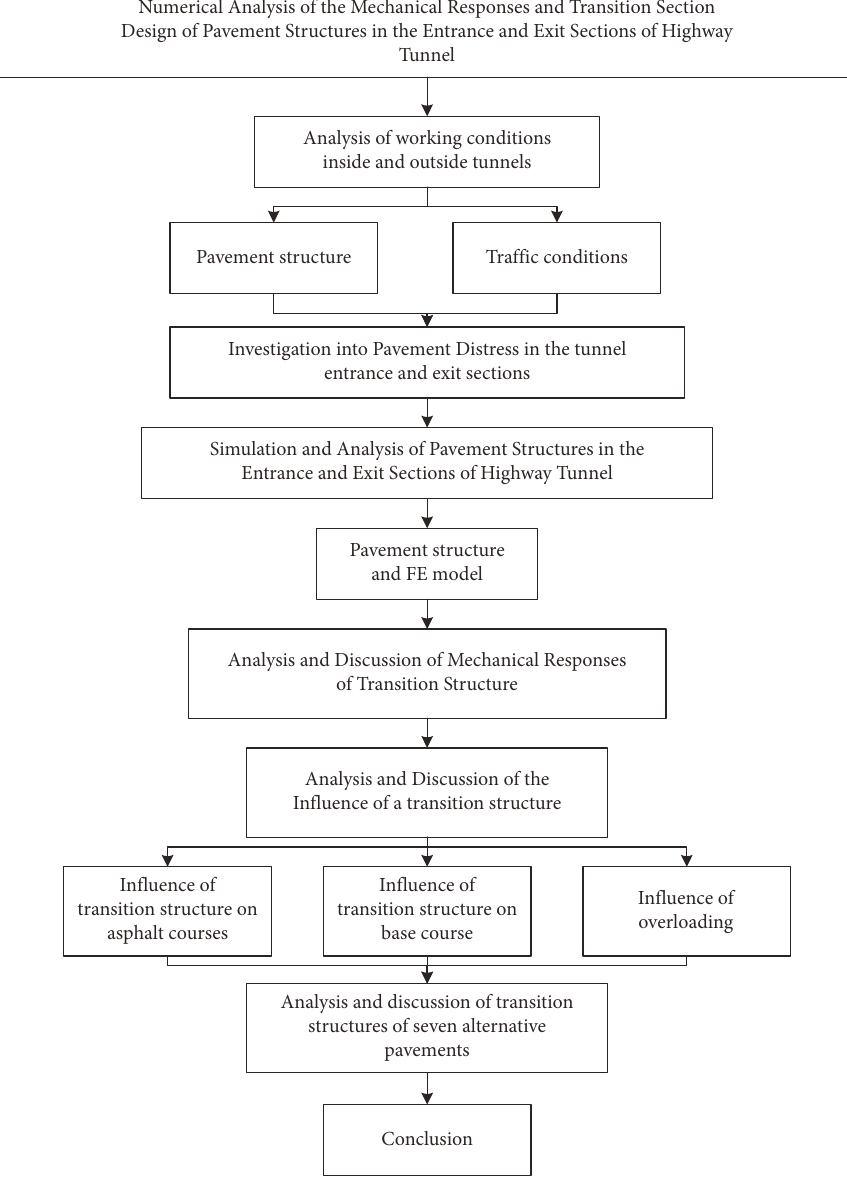
Figure 1: Flowchart of this